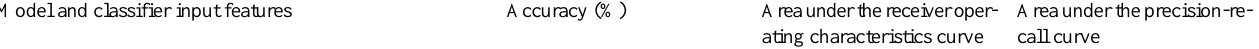
Table 1. Performance comparison of the best performing models using mixture model and hidden Markov model posteriors as classifier input features. Multilayer perceptron using 7 days of observations as input features 0.700.8165Mixture model